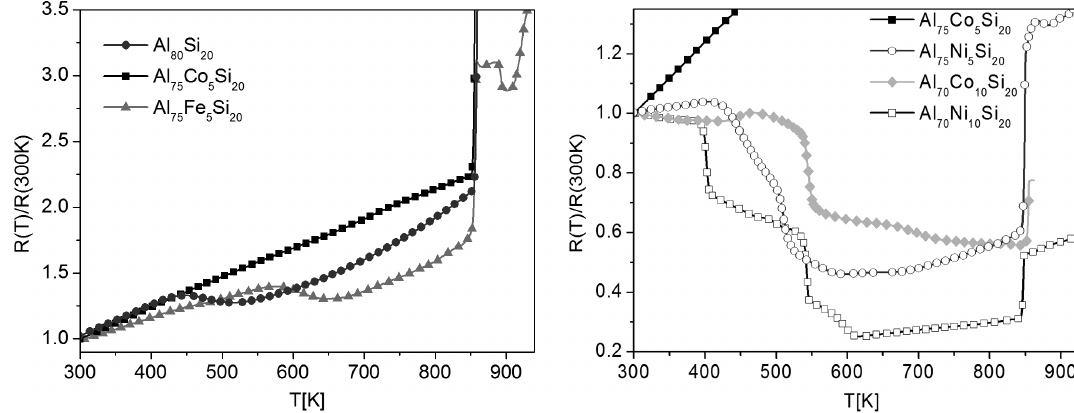
Figure 2. Temperature dependence of relative electrical resistivity (linear heating 10K/min).